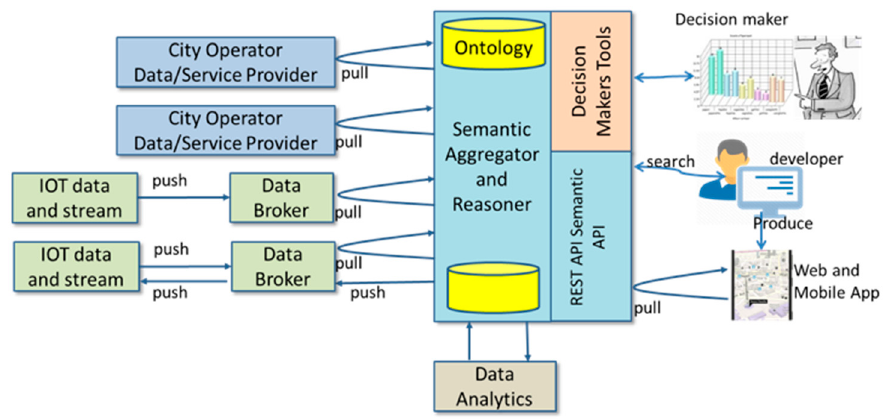
Figure 6. Data aggregation system.